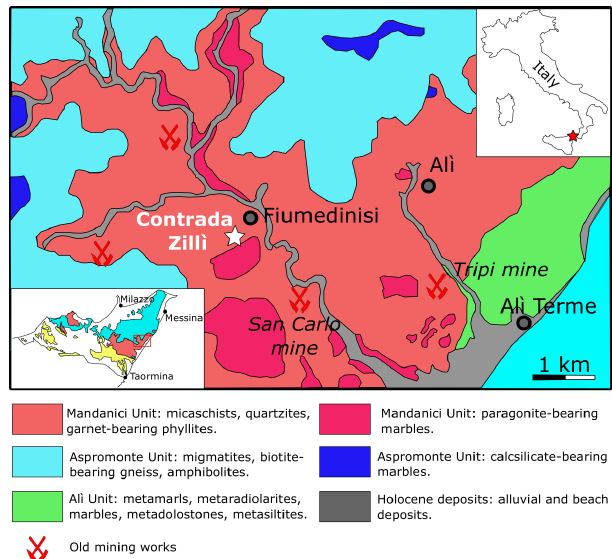
Figure 1. Geological sketch of the Fiumedinisi area (modified after Oteri et al., 1986). The inset on the left shows the location of the studied area (red box) within the Peloritani Mountains. In the inset, the main tectonic units are shown: light blue = Aspromonte Unit; pink = Mandanici Unit; yellow = South Peloritan Complex (after Ferla and Omenetto,